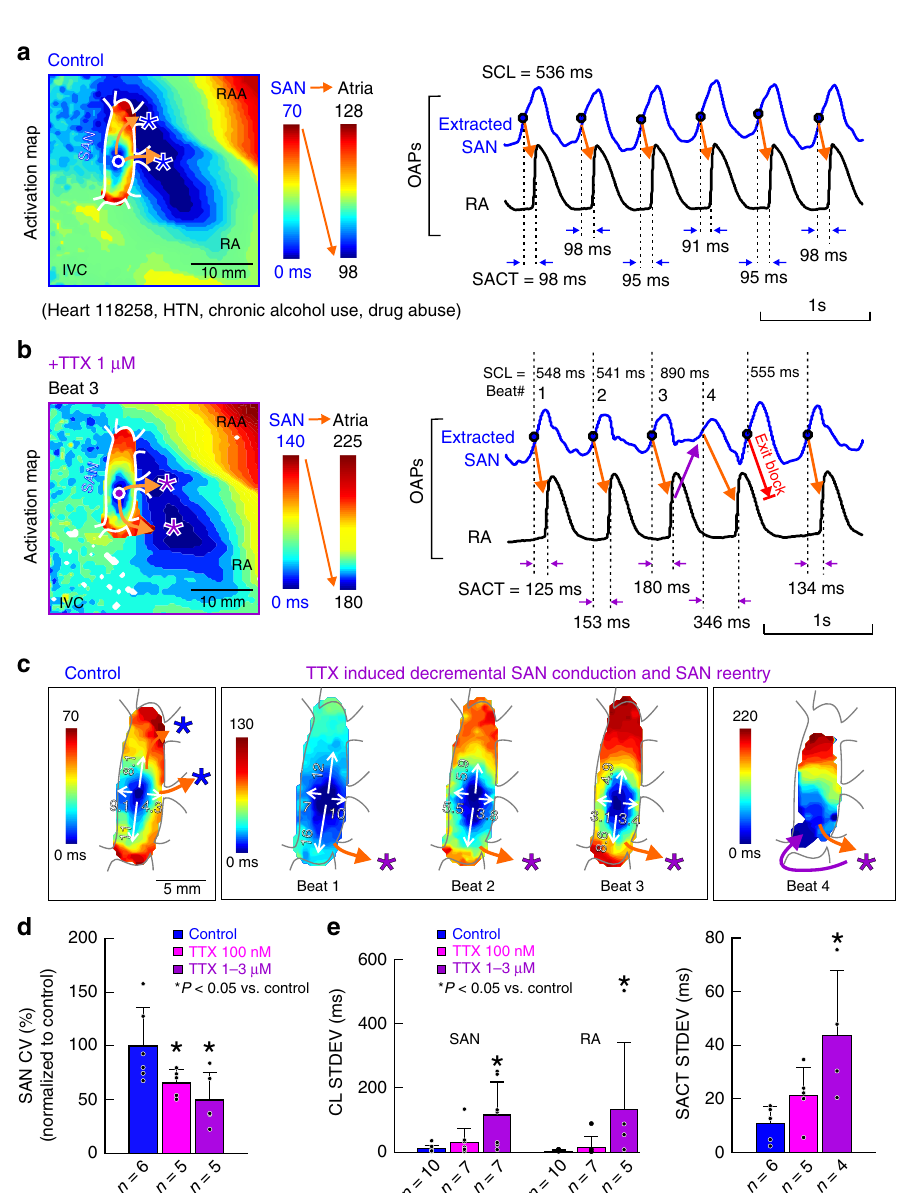
Fig. 2 SAN intranodal conduction impaired by nNav and cNav blockade. Activation map (left) and OAP recordings (right) show sinoatrial node (SAN) activation and conduction at control ( a ), and after blocking cardiac Nav with 1 µ M TTX ( b ). Dot indicates the leading pacemaker inside the SAN; asterisk indicates the earliest atrial activation site; arrow indicates the SAN conduction pathway. c Left: SAN activation map showing intranodal conduction at control condition. Middle to right: SAN activation maps of four sequential beats showing the gradual decrease of intranodal conduction and SAN macro- reentry after cardiac Nav blockade with 1 µ M TTX. White arrows indicate the direction of intranodal conduction; numbers beside arrows denote SAN conduction velocity (cm/s). d Summary of SAN conduction velocity (CV) changes at 100 nM and 1 – 3 µ M TTX ( n = 5) compared with control ( n = 6). e TTX increased the beat-to-beat variation shown as SD (STDEV) of SAN (control: n = 10; TTX 100 nM and 1 – 3 µ M: n = 7) and atrial (control: n = 10; TTX 100 nM: n = 7; 1 – 3 µ M: n = 5) cycle length (CL), and sinoatrial conduction time (SACT) during control ( n = 6), TTX 100 nM ( n = 5), and TTX 1 – 3 µ M ( n = 4). Data presented as mean ± SD. IVC inferior vena cava, OAP optical action potential, RA (A) right atrial (appendage), TTX tetrodotoxin. Data in d and e were represented in mean ± SD. Asterisks in d and e indicate P < 0.05 vs. control by two-tailed t -test. Source data are provided as a Source Data fi